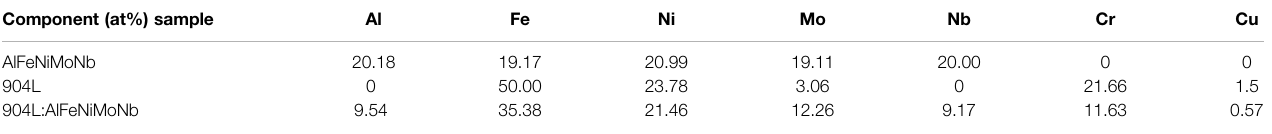
TABLE 1 | The actual composition of the test samples detected by energy dispersive spectroscopy (EDS) technology. Component (at%) sample Al Fe Ni Mo Nb Cr Cu AlFeNiMoNb